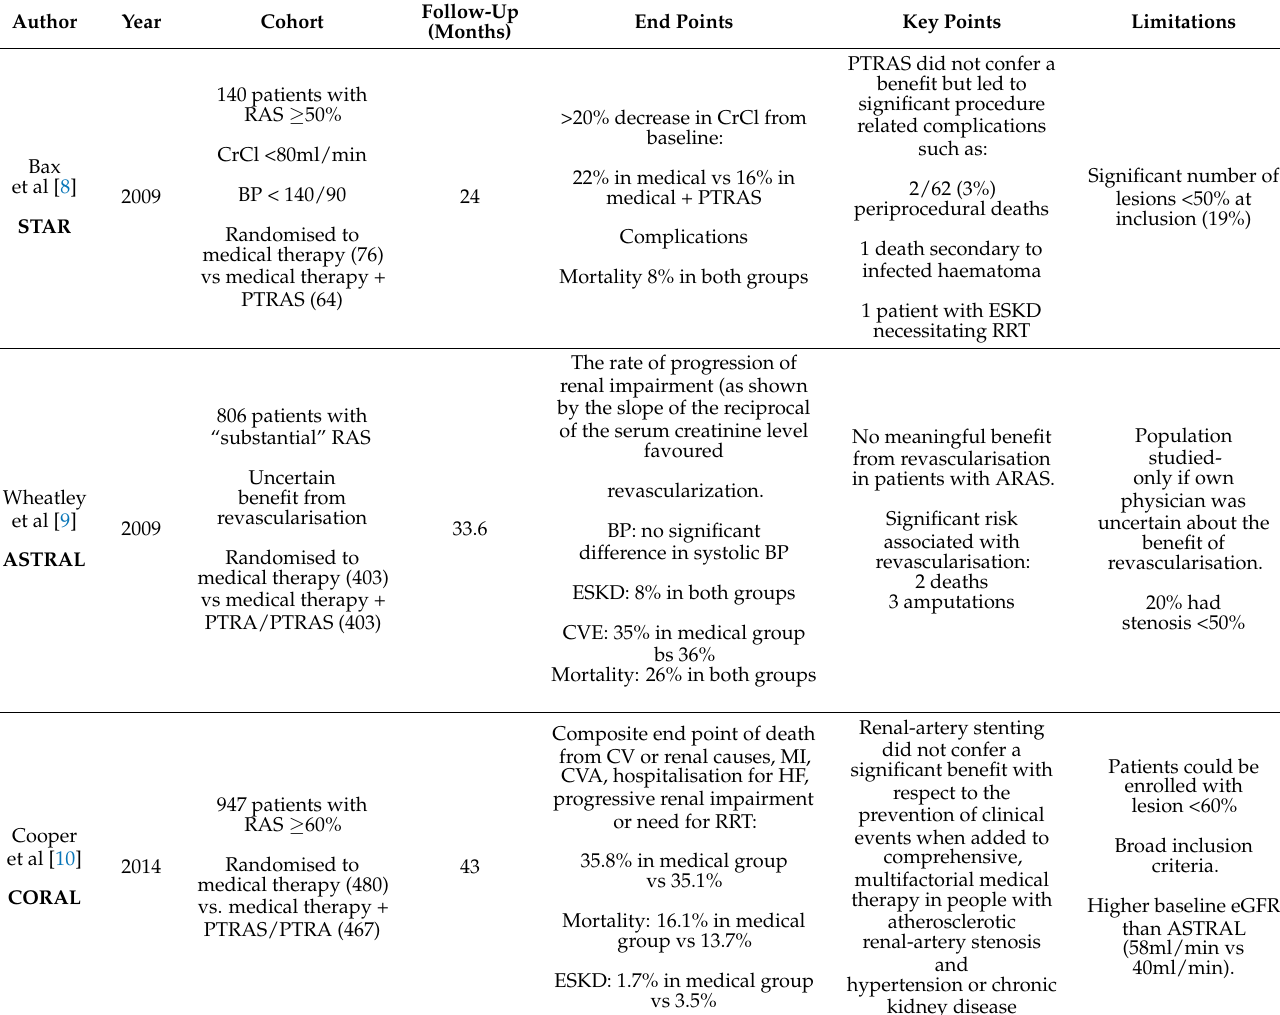
Table 1. Randomised control trials of renal revascularisation versus medical